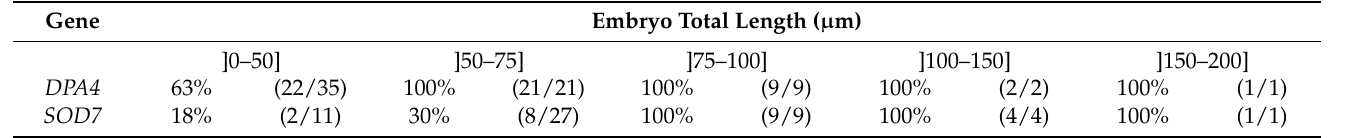
Table 4. Frequency of DPA4 or SOD7 expression in wild-type embryos depending on the embryo size and the